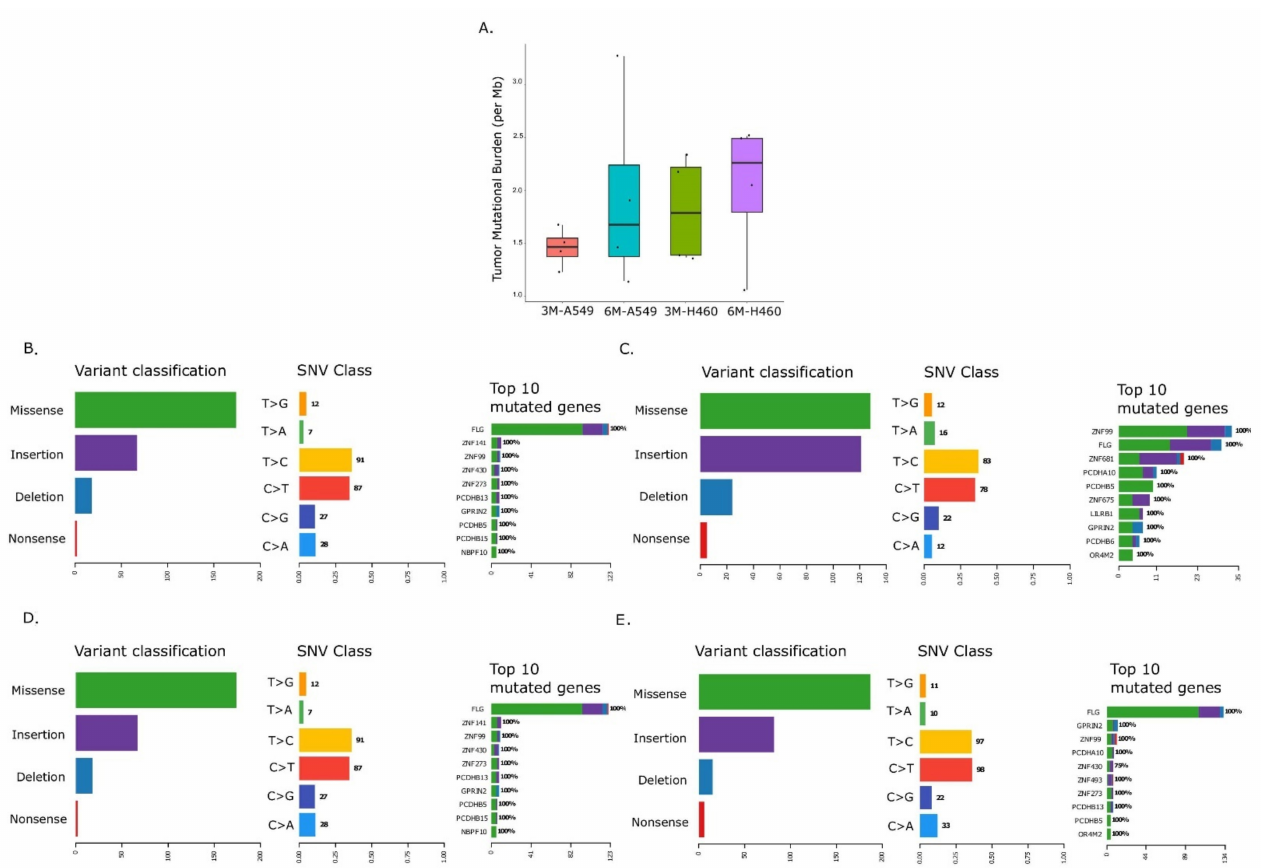
Figure 3. Mutational analysis of long-term WPSC treatment of lung cancer cell lines. WPSC treatment led to an increase in the tumor mutational burden (TMB), represented as an increase in total mutations per megabase in both A549 and H460 cell lines ( A ). Summary of mutations in A549 and H460 cell lines, respectively, treated with WPSC for 3 months ( B , D ) and 6 months ( C , E ). In sum, we found an increase in TMB in six-month, WPS-treated cancer cell lines, with an increase in C to T and T to C transitions and frameshift insertions of 1–4 bp homopolymer lengths. We identified genes with an adaptive potential, with GPRIN2 being common across both cell lines. Finally, we found differentially mutated genes in response to the long-term exposure of WPS, including genes from the MYC and NOTCH